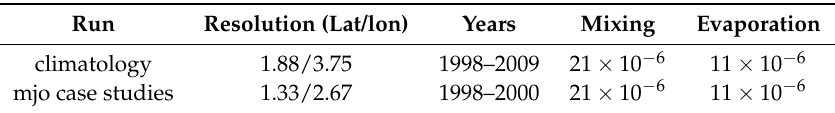
Table 1. Lagrangian model